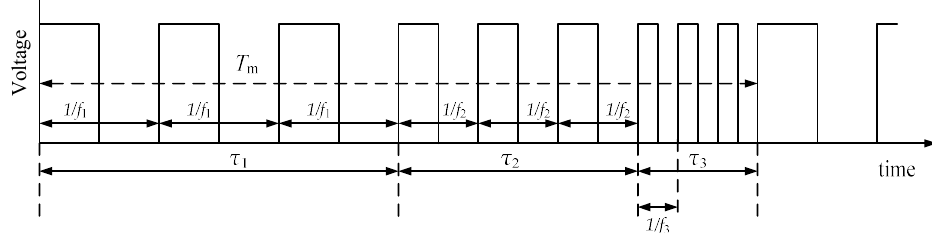
Figure 4. Waveform of square signal with three-switching-frequency technique. During τ 1 the system operates at frequency f 1 , during τ 2 the system operates at frequency f 2 , but during τ 3 the system operates at frequency f 3 .